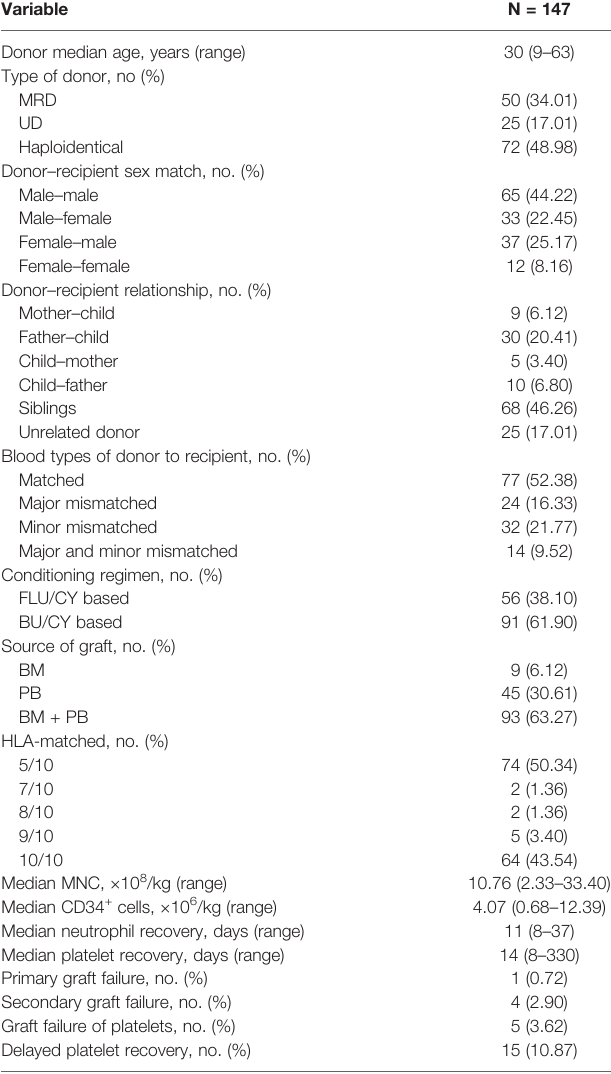
TABLE 2 | Characteristics of SAA patients and donors in allo-HSCT group.